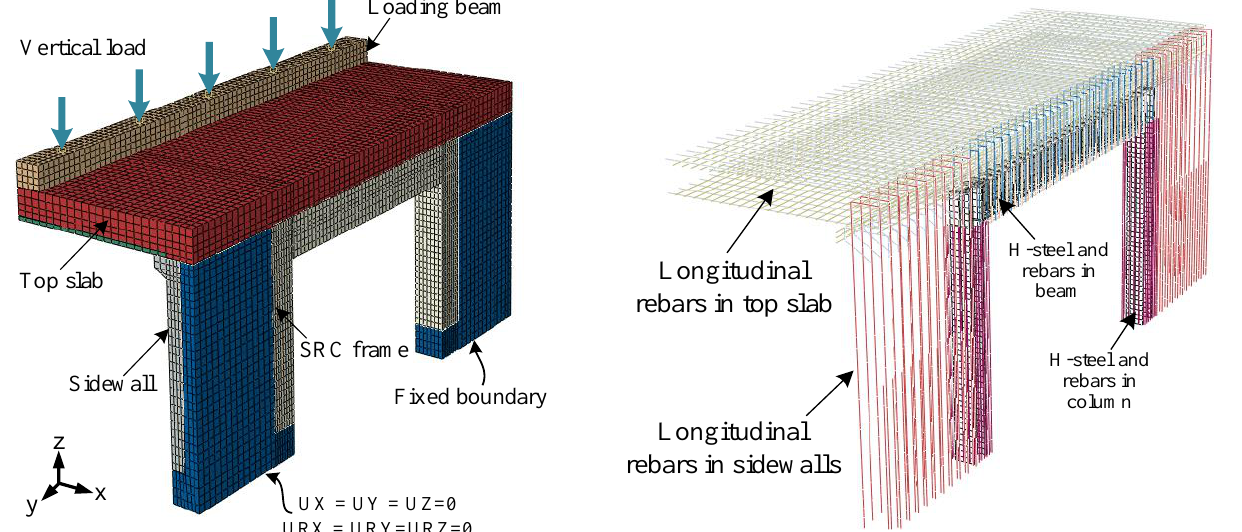
Figure 16. Meshed model and the loading